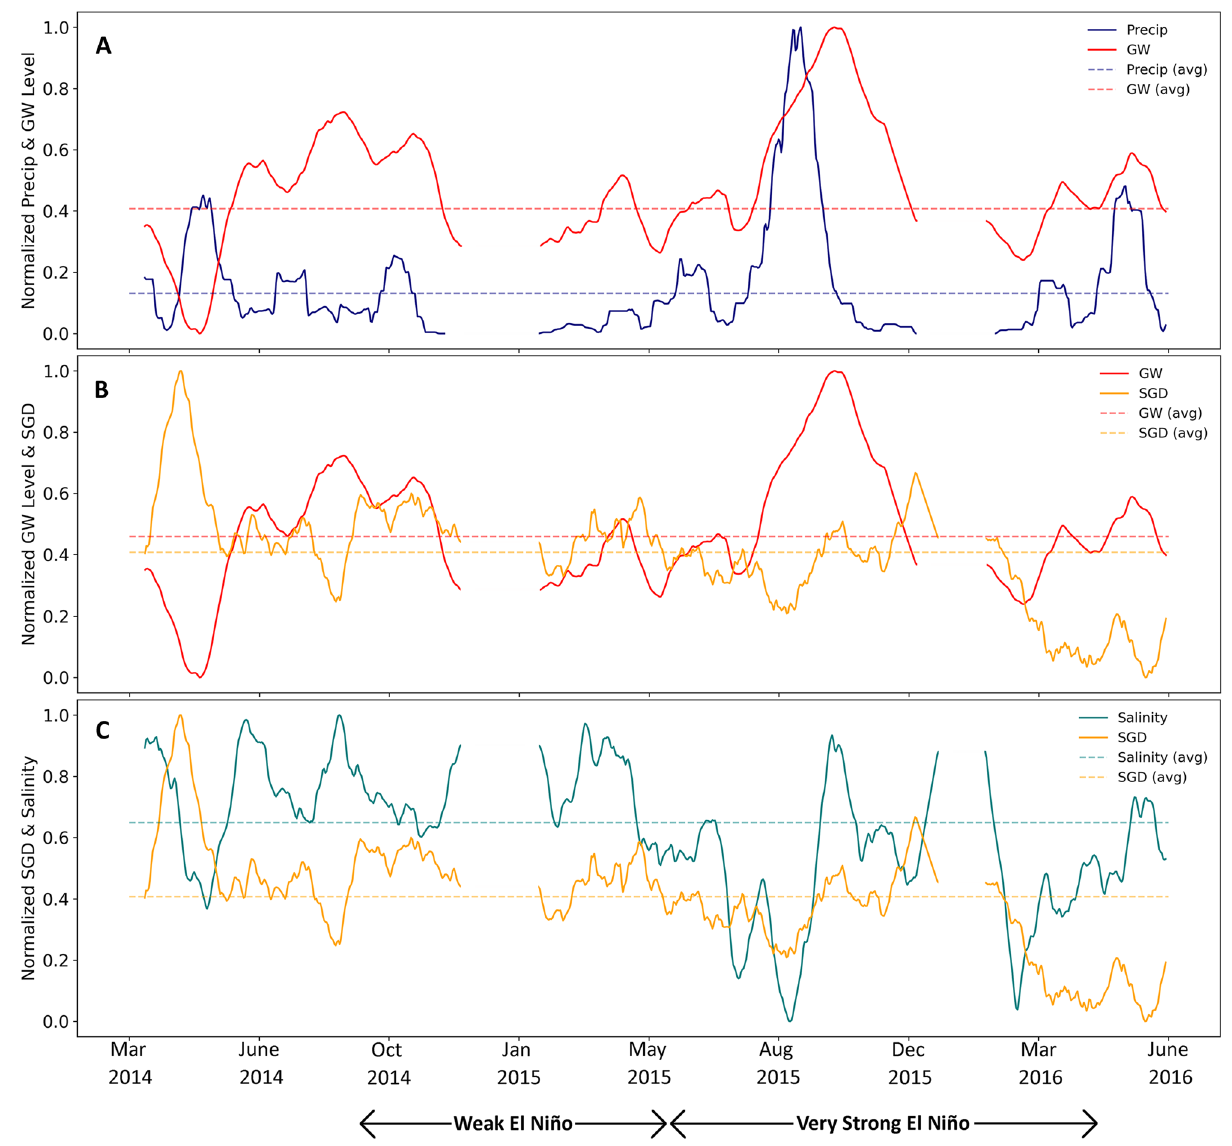
Figure 4. 25-h trend component from the time series decomposition. Mean values for each variable are shown in the dashed lines. ( A ) normalized precipitation (blue) and groundwater levels (red), ( B ) normalized groundwater levels (red) and SGD (yellow), and ( C ) normalized SGD (yellow) and coastal salinity (teal) with respect to time. Most of the time series coincided with El Niño (ONI ranging from 0.6 in October through December 2014 to 2.6 in November 2015 through January